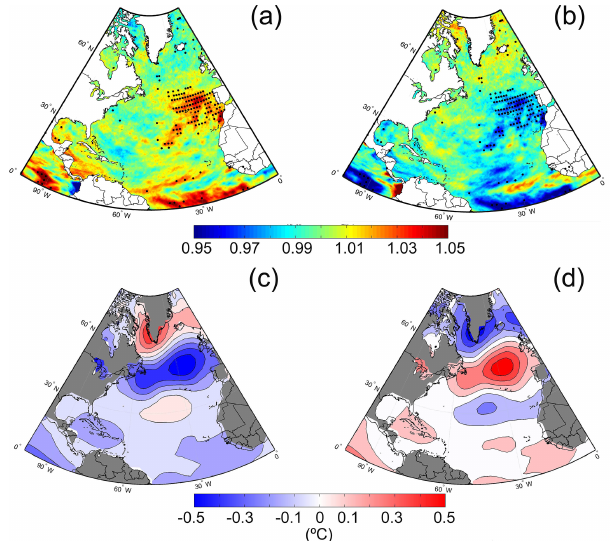
Figure 3. Ratio between the positive (a) and negative (b) summer (JAS) FTLE anomalies and the summer FTLE mean. Summer SST anomalies in the Atlantic Ocean for years with positive (c) and neg- ative (d) summer FTLE anomalies, respectively. Pointed areas in panels (a) and (b) display the significant differences between both phases obtained from a two-sided Wilcoxon rank-sum test.